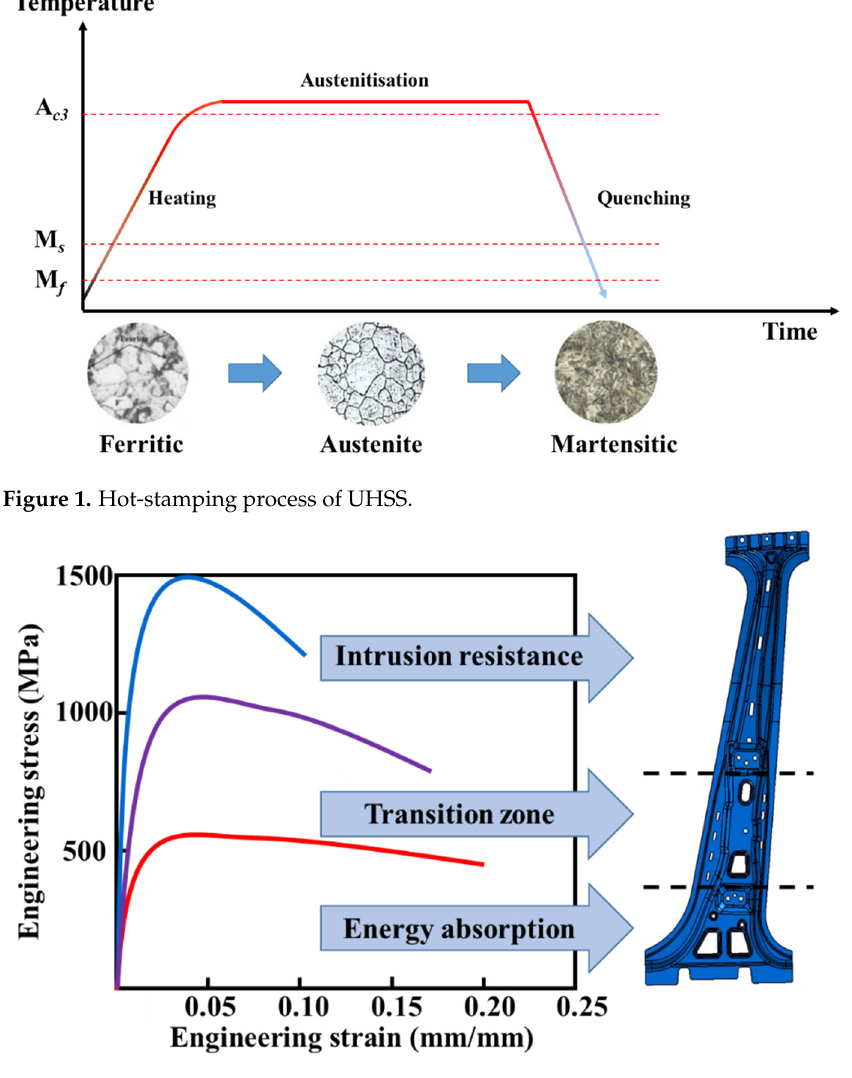
Figure 2. Schematic of the B-pillar with different properties.